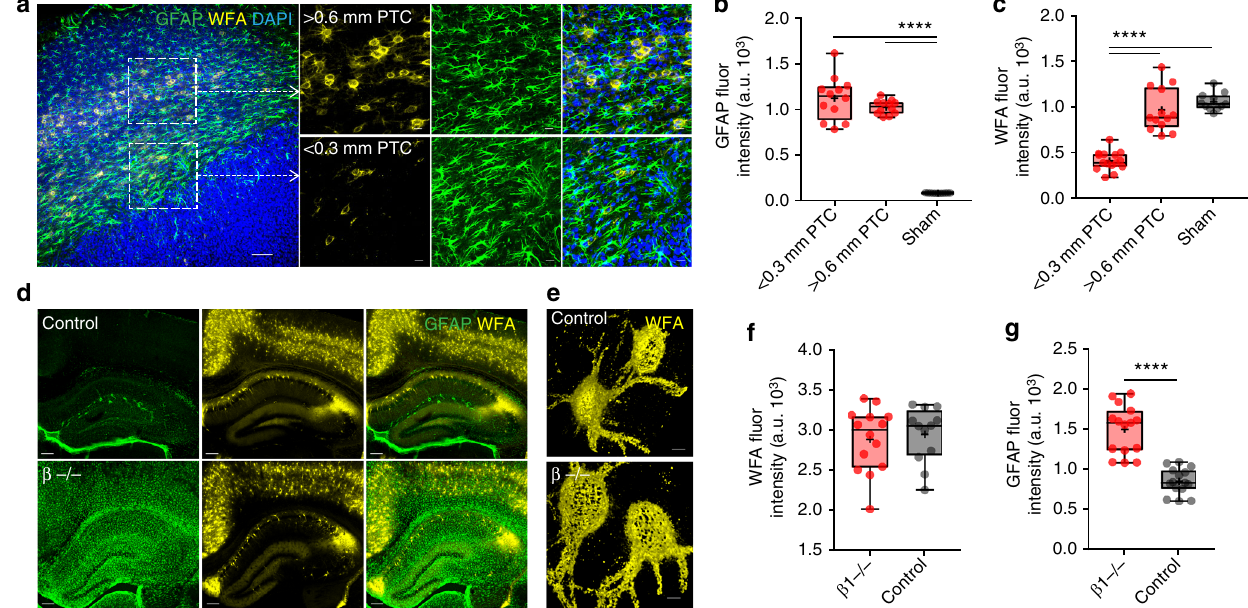
Fig. 4 PNN disintegration is not correlated with astrogliosis. a Confocal images of GBM22 PTC labeled with GFAP (green), WFA (yellow), and DAPI (blue) showing reactive astrocytes near disintegrated PNNs (bottom square and corresponding lower panels) and intact PNNs (upper square and corresponding upper panels) in proximal (0.0 – 0.3 mm) and distal (>0.6 mm) PTCs, respectively. Scale = 100 µ m in the main image and 20 µ m in the magni fi ed images. Sham-treated controls did not show any reactive astrogliosis (Supplementary Fig. 1e). b High GFAP expression in the PTC (1127 ± 68.23, n = 5 mice) compared to sham (97.51 ± 0.83, n = 6 mice), but similar between proximal and distal PTCs (proximal PTC, 1127 ± 68.23; distal PTC, 1031 ± 22.08; n = 5 mice). c WFA intensity was signi fi cantly lower in proximal PTC (0.0 – 0.3 mm, 418.9 ± 27.06) compared to both distal PTC (>0.6 mm, 970.6 ± 66, n = 5 mice) and sham (1063 ± 28.47, n = 6 mice). d Representative images of GFAP and WFA immuno fl uorescence in wild-type (control) (top) and β 1 − / − (bottom) cortical sections showing reactive astrogliosis in the latter and intact PNNs. Scale = 200 µ m. e Representative high-magni fi cation 3D volume projection images of individual PNNs showing comparable WFA intensity and PNN architecture in wild-type (control) and β 1 − / − . Scale = 5 µ m. f Box and whisker plot showing comparable WFA intensity in wild-type (control) (2942± 98.72) and β 1 − / − (2881 ± 105.3). n = 8 mice. g Signi fi cantly higher GFAP expression in β 1 − / − (1500± 77.83) than wild-type (control) (856.7 ± 42.13). n = 8 mice. **** P < 0.0001, one-way ANOVA, Tukey ’ s post-hoc test in ( b ) and ( c ); unpaired t test in ( f ); and Welch ’ s t test in ( g ). All fl uorescence intensities represent arbitrary units of fl signi fi cantly lower than that in the PTC and glioma mass (Fig. 5b, Supplementary Fig. 2b).